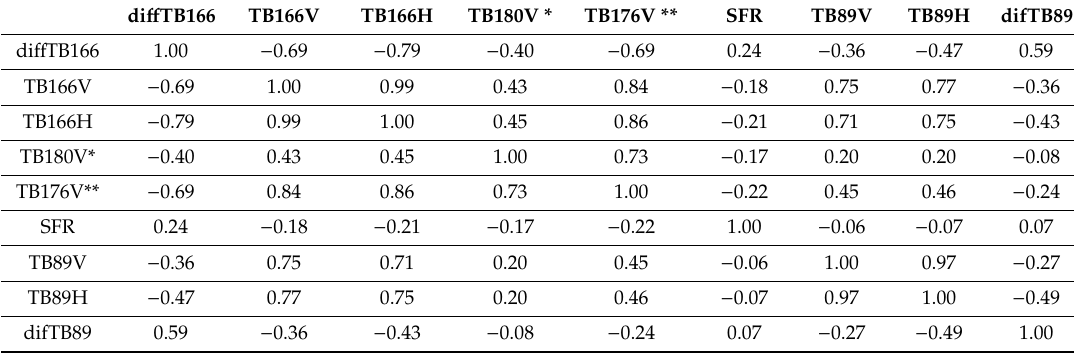
Table 1. Partial correlation coe ffi cients over land among GMI brightness temperature measurements and station measured snowfall rate (SFR). For the variable names, “TB” denotes the brightness temperature, “H” and “V” denote vertical and horizontal polarizations, and the numbers denote the channel center frequency. “di ff ” refers to the vertical and horizontal brightness temperature di ff erence at a specific frequency. Control variables are the measured surface temperature and relative humidity. di ff TB166 TB166V TB166H